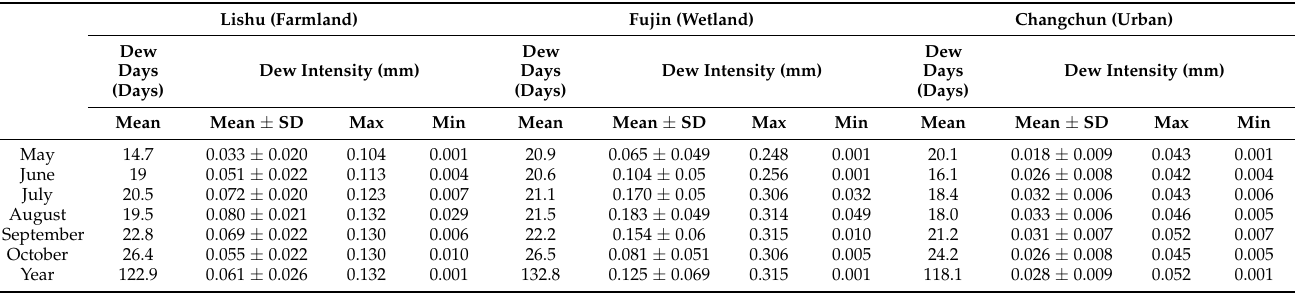
Table 2. The monthly and yearly characteristic values of dew days and daily dew intensity in Lishu, Fujin and Changchun from 2015 to 2021.